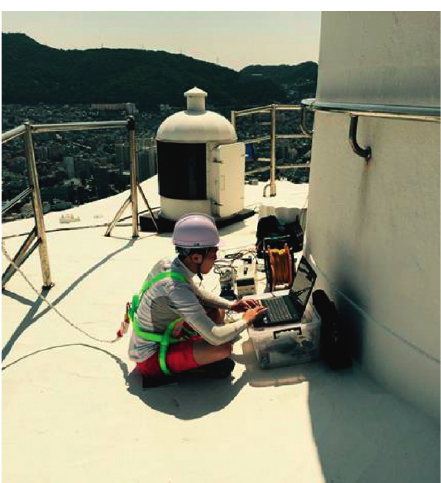
Figure 2: Field measurement of ambient vibrations.